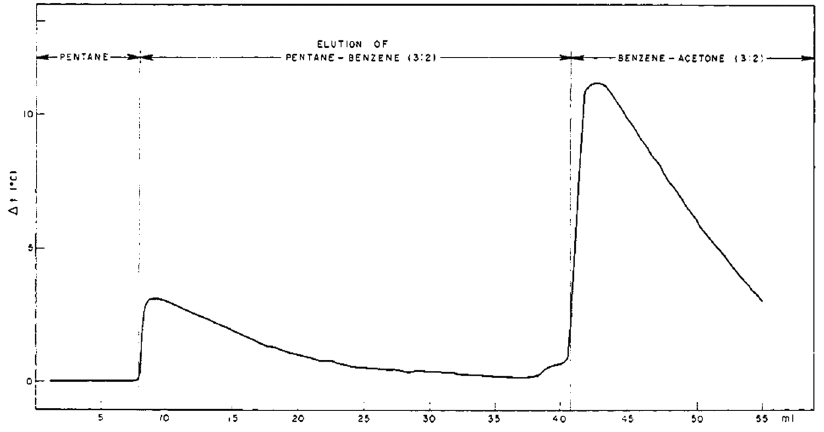
Figure 2. The sharp rise of temperature at the arrival of a liquid front for which the solid phase has a higher affinity, compared to the resident liquid 5